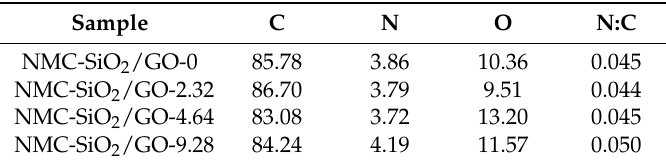
Table 2. Elemental composition (at %) of the synthesized carbon.